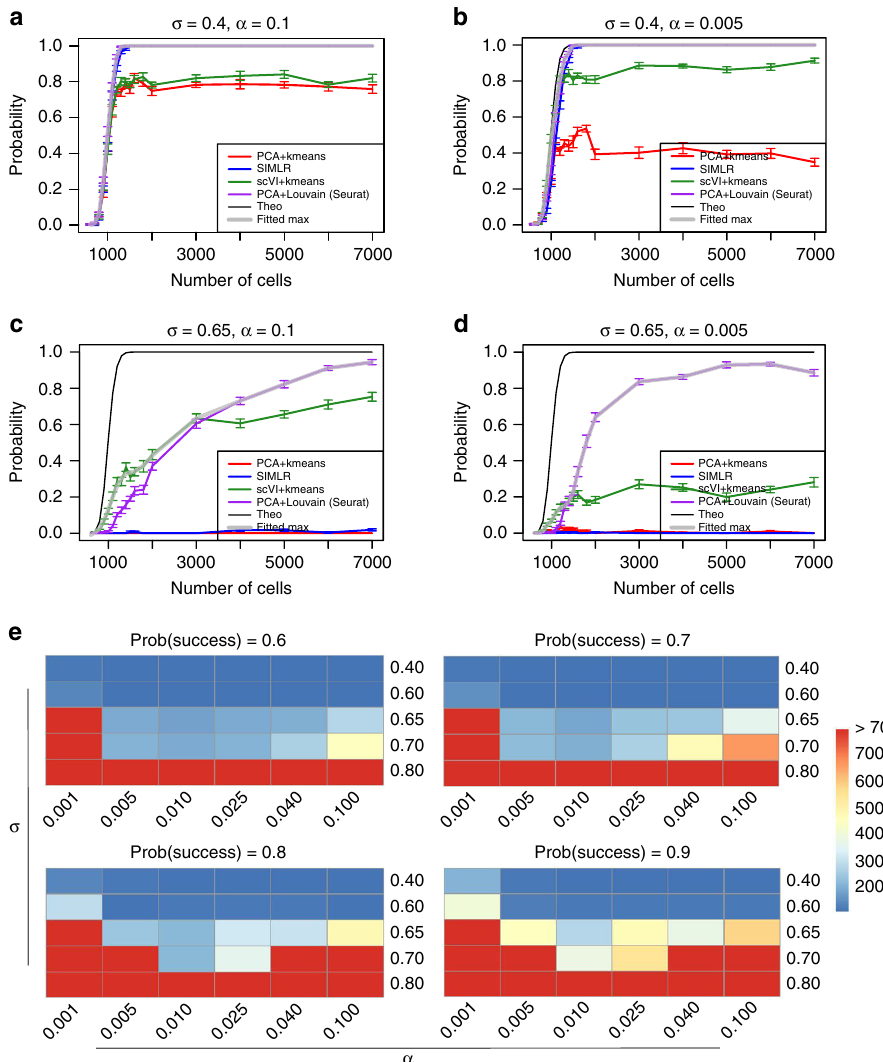
Fig. 8 The number of cells needed to detect a rare population. We generate fi ve populations according to the tree structure shown in Fig. 3 and set population 2 as the rare population which accounts for 5% of the cells. Other populations share 95% of the cells evenly. The criteria of detecting the rare population are that at least 50 cells from this population are correctly detected and the precision (positive predicted value) is at least 70%. a – d The probability of detecting the rare population when sequencing N ( x- axis) cells under different σ and α con fi gurations, with different clustering methods. The black curve represents the theoretical probability from the binomial model, assuming that all cells sequenced are assigned correctly to the original population. The gray curve with transparency takes the maximum value at each data point from all four clustering methods with smoothing. Error bars are standard deviation over 20 randomizations. e The heatmaps show the number of cells needed to sequence under different con fi gurations of σ and α to detect the rare population with success rates 0.6, 0.7, 0.8, 0.9, always using the best clustering method. Data used to plot a – e can be found in Source